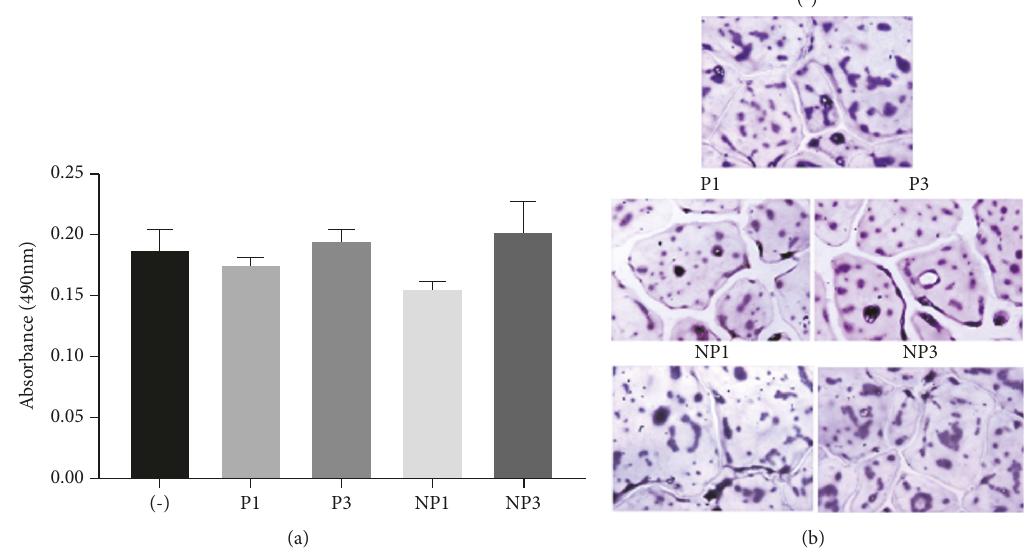
Figure 5: MTT assay and TRAP-staining of osteoclasts after treatment with TAT-fused sNT-LPL peptides (P1 and P3) and nanoparticles (NP1 and NP3). Osteoclasts were treated with indicated peptides or nanoparticles for 4h in the presence of TNF- 𝛼 and bone particles. Next, cells were subjected to the calorimetric MTT assay as described in the Methods to determine the proliferation effects (a). TRAP staining was performed to determine the cell morphology or phenotype of osteoclasts (b). Osteoclasts untreated with peptides but treated with TNF- 𝛼 and bone particles were used as controls (-). MTT assay confirmed that proliferation activity is not affected. Morphological characterization by TRAP-staining and attachment of osteoclasts to culture dishes suggest that cells are active and viable. Magnification-40X. These results represent one of the two experiments performed with similar